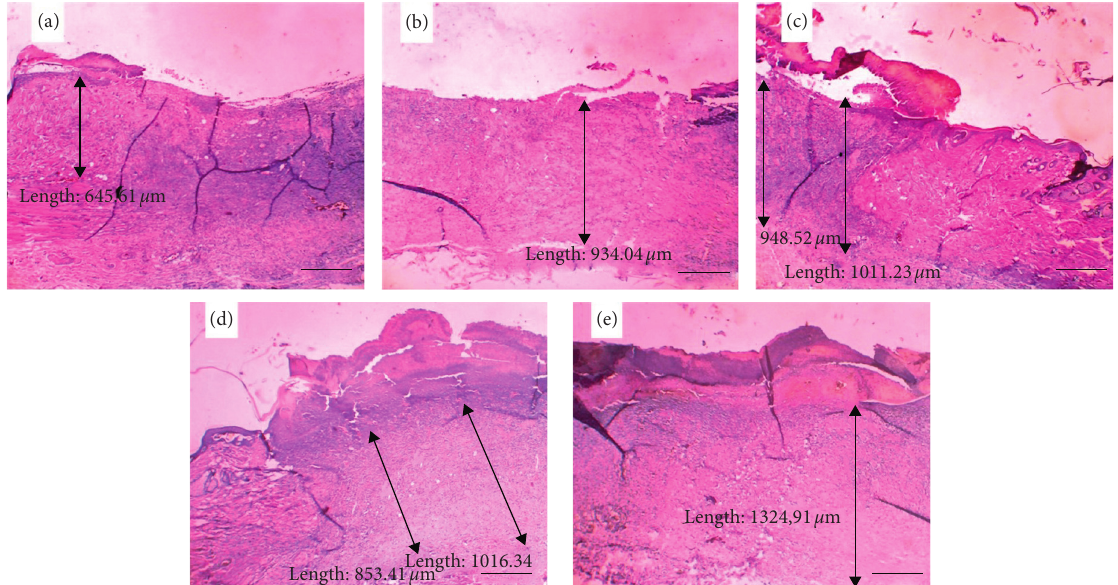
Figure 4: The thickness of collagen on day 3. (a) Control group with nonozonated Aloe vera oil. (b) Control group with gentamicin application. (c) Treatment group with 600mg ozonated Aloe vera oil. (d) Treatment group with 1,200mg ozonated Aloe vera oil. (e) Treatment group with 1,800mg ozonated Aloe vera oil. Scale bar 100 μ